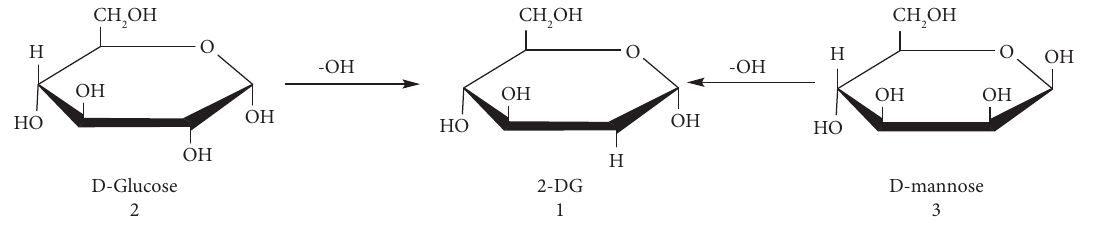
Figure 4: Preparation of 2-DG from D-glucose and